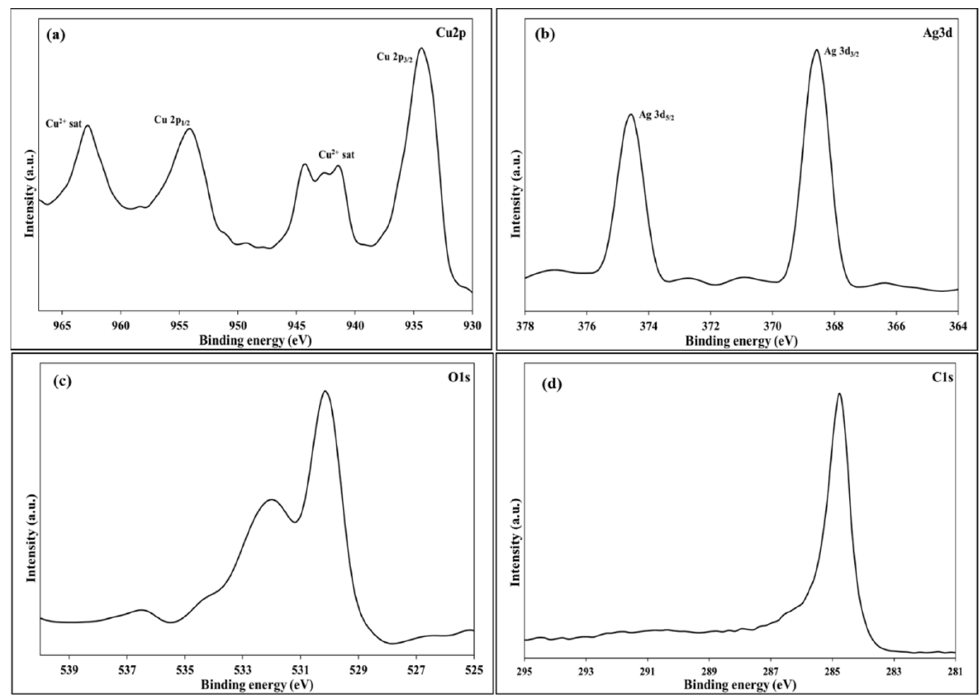
Figure 4. XPS spectra of ( a ) Cu2p, ( b ) Ag3d, ( c ) O1s and ( d ) C1s core levels of CuOxAg/KB cata- lyst.